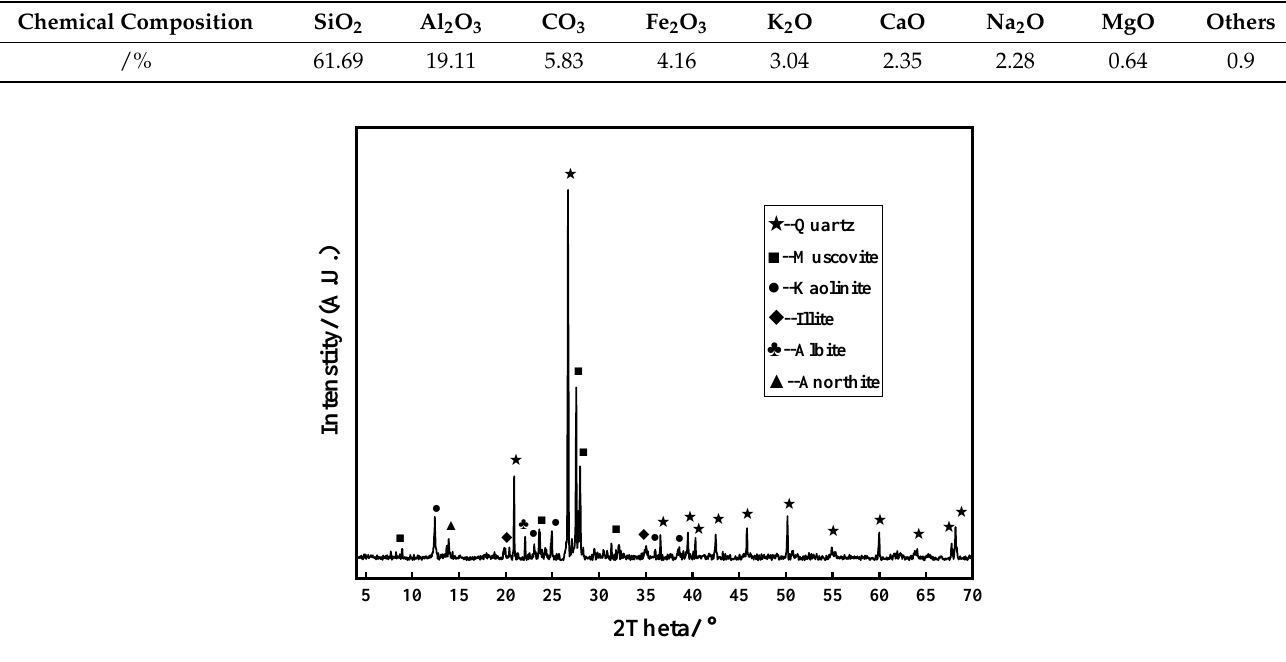
Figure 1. XRD pattern of coal gangue. Table 2. The basic properties of fine and coarse aggregate.